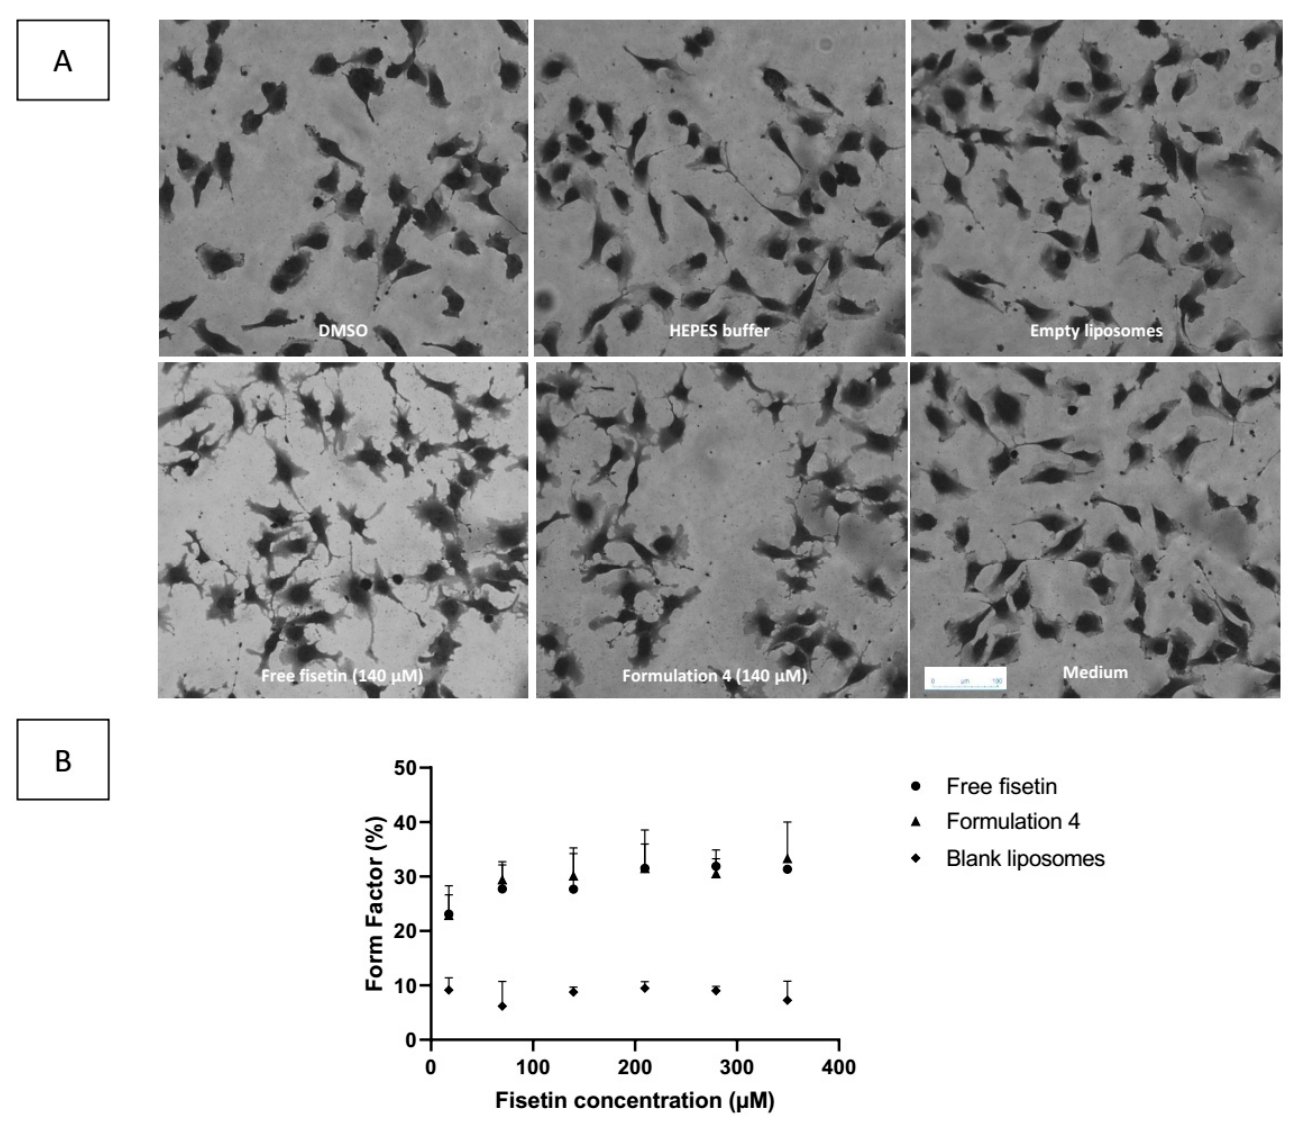
Figure 6. Effect of free fisetin and liposomal fisetin on endothelial Ea.hy 926 cell line (mean ± SD, n = 4). ( A ) modification of EA.hy 926 cells’ morphology (magnification ×125). ( B ) form factor of empty liposomes (diamond), free fisetin (circle) and fisetin-loaded formulation 4 (triangle). Table 3. IC50 values ( µ M) as function of fisetin on EA.hy 926 cell line (mean ± SD, n = 4). * p < 0.05 versus free